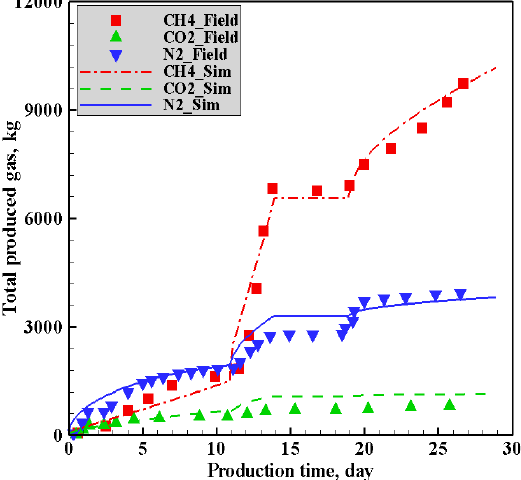
Figure 9. Accumulations of produced CH 4 , CO 2 and N 2 with the production time.